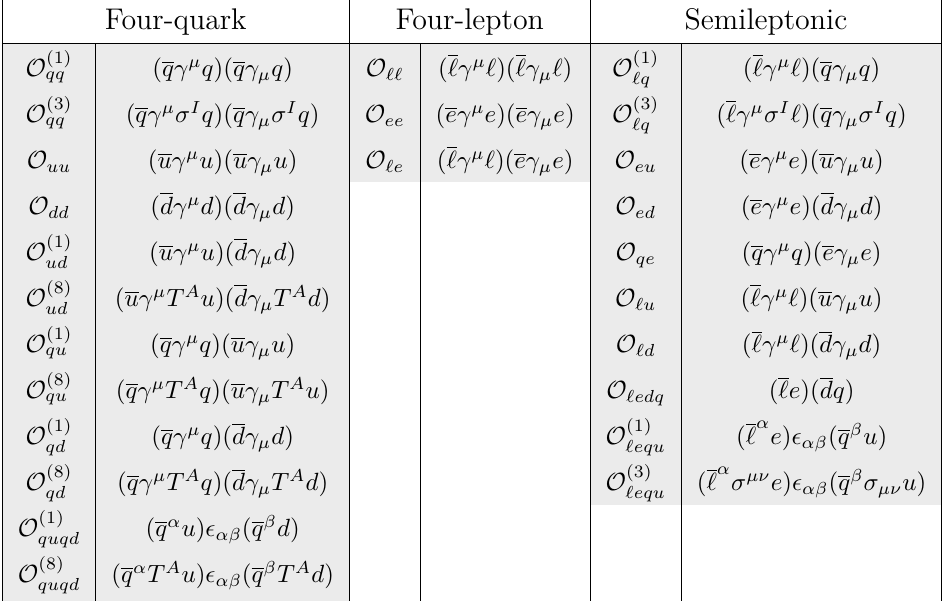
Table 9 . Four-fermion operators. Generation indices are suppressed.